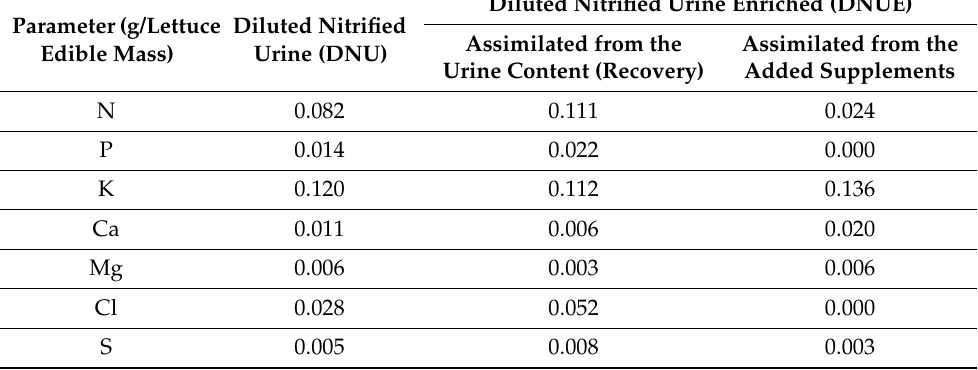
Table 5. Assimilated elements per edible mass of lettuce produced in the DNU treatment (diluted urine), where all assimilation is recovery, and for the DNUE treatment, where added micronutrients were added; only the elements from the urine fraction are considered as